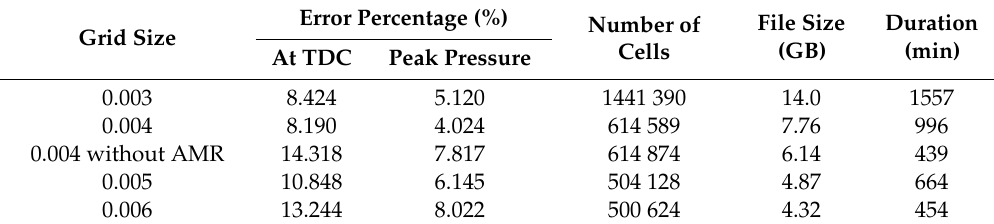
Figure 3. Pressure of diesel fuel from the simulation with different grid sizes and with and without adaptive mesh refinery (AMR) function when the engine is running at 1600 RPM compared with the experiment. Table 5. Comparison of data sizes, simulation durations, and error percentages from the pressure during combustion with different grid sizes.